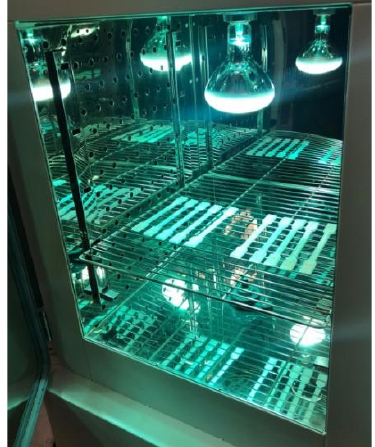
Fig. 3 Accelerated UV source with 3D printed